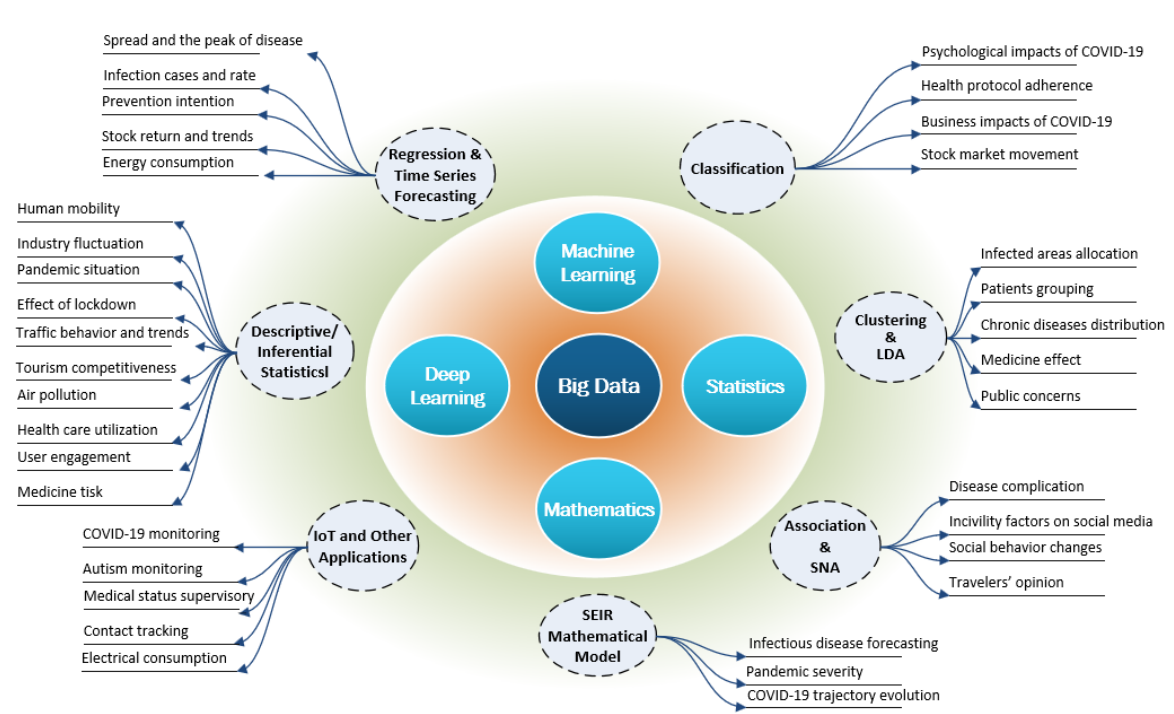
Figure 5. Knowledge mapping of analytical